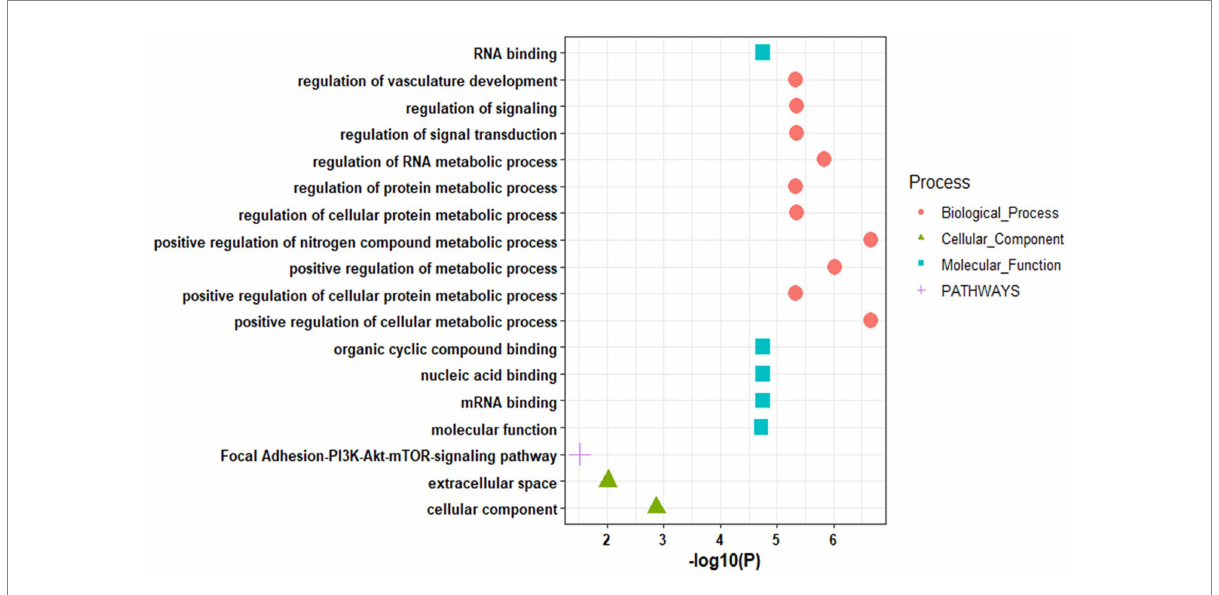
FIGURE 5 Gene ontology of top 5 miRNAs interacting with kinases.